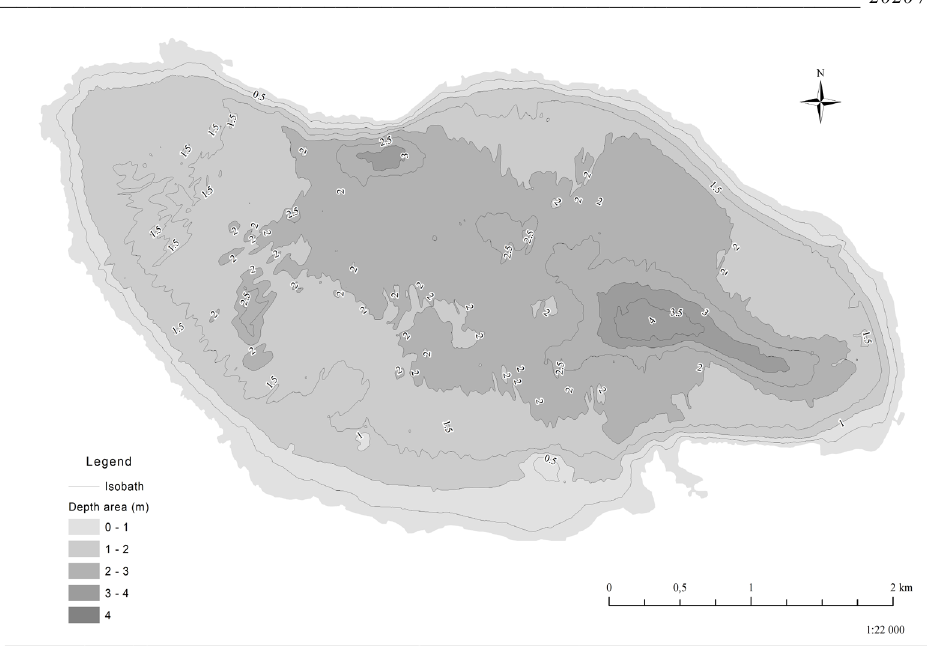
Fig. 1. Lake Zebrus bathymetric